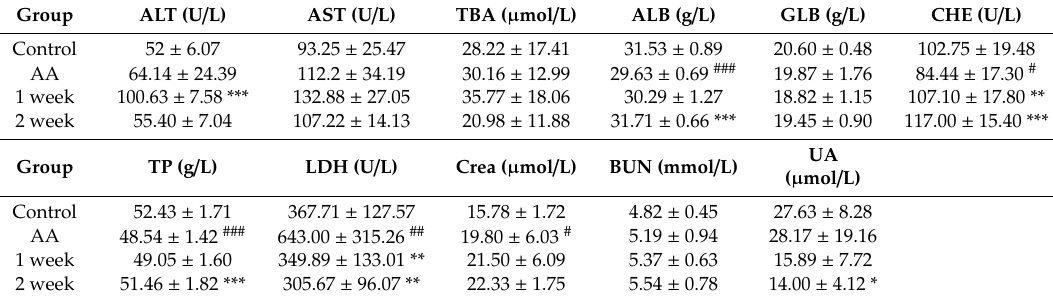
Figure 1. Liver histological structure of rats with 30 mg/kg/d of aristolochic acid I (AAΙ) oral administration for one week and AAΙ discontinuance for one week and two weeks. ( A ) No obviously histopathological changes in the liver of the control group. ( B ) Diffuse swollen (in the yellow box) and vacuolar degeneration in hepatocyte (a → ) in the liver of AAΙ group. ( C ) and ( D ) Mild focal hepatocyte swollen and vacuolar degeneration (a → ) in the liver of one-week group and two-week group, respectively. ( E ) No obviously histopathological changes in the kidney of control group. ( F ) The epithelial cell of renal tubule in cortex showed multiple focal swollen and degeneration (a → ). The acidophily increased in cytoplasm (b → ). Necrosis, karyopyknosis, karyolysis, and even disappearance (c → ) in individual epithelial cell. Hyperplasia of the mesenchymal cell around the injury renal tubules (d → ). ( G ) and ( H ) Multiple focal swollen, degeneration, lumen narrowing, mesenchymal cell hyperplasia in the kidney of one-week group and two-week group, respectively. Table 1. E ff ect of AAI on serum biochemical indexes in four